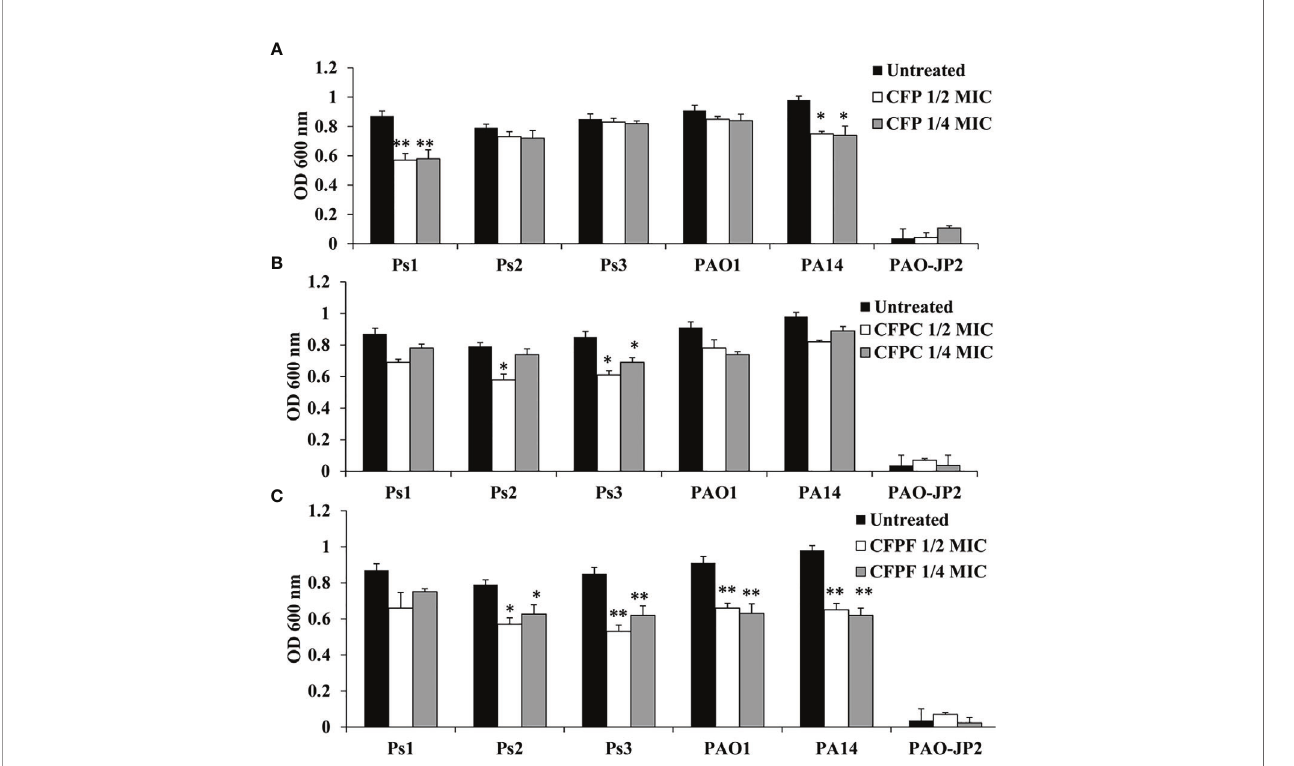
FIGURE 2 | Protease production; Effect of sub-MICs; 1/4 and 1/2 of Cefoperazone (CFP) (A) Cefoperazone-Cobalt complex (CFPC) (B) and Cefoperazone-Iron complex (CFPF) (C) on total protease production in P. aeruginosa strains, Ps1, Ps2, Ps3, PAO1, PA14 and PAO-JP2 (negative control) compared to the untreated cultures. Error bars represent S.D. (n = 3), * p ≤ 0.05, and ** p ≤